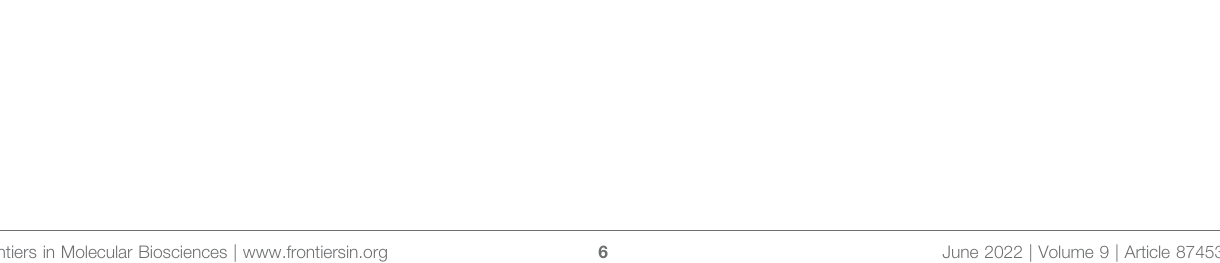
Frontiers in Molecular Biosciences |